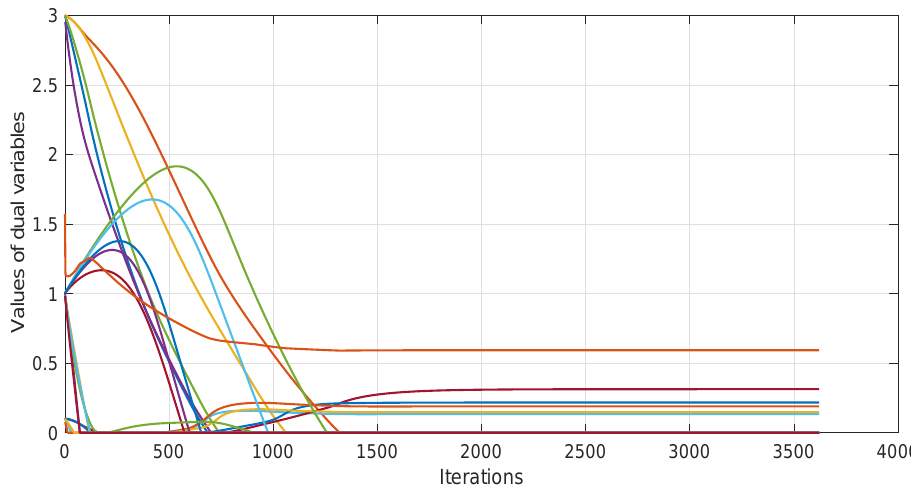
Figure 7. Convergence of dual